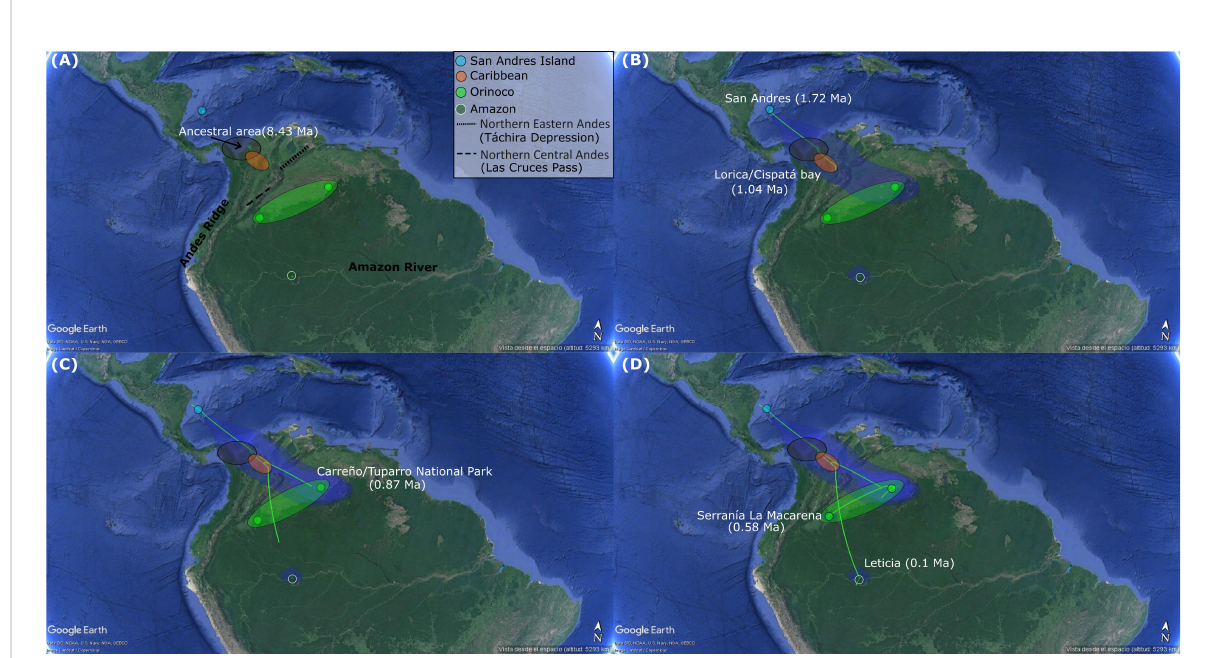
FIGURE 3 Spatiotemporal reconstruction analysis using nuclear RADseqs (35,507 SNPs) and 1,047 bp of R35 Intron, based on a Relaxed Random Walk analysis in continuous space and time for K. scorpioides populations from insular (San Andre ́ s) and continental (Caribbean, Orinoco and Amazon) Colombia, inferred in BEAST v1.8.2 and SPREAD3, and visualized in GoogleMaps. Graph is showing the hypothetical ancestral area (gray circle) and the spatial patterns (green lines) of colonization/establishment and theirs ages, for K. scorpioides in each sampling region San Andrés (A) , Caribbean (Lorica/Cispatá Bay) (B) , Orinoco (Carreño-Tuparro National Park and Serranía La Macarena) (C) , Amazon (Leticia) (D) . All the observed colonization ages are median heights into 95% credibility intervals of the Bayesian Maximum Clade Credibility Tree topology used in the